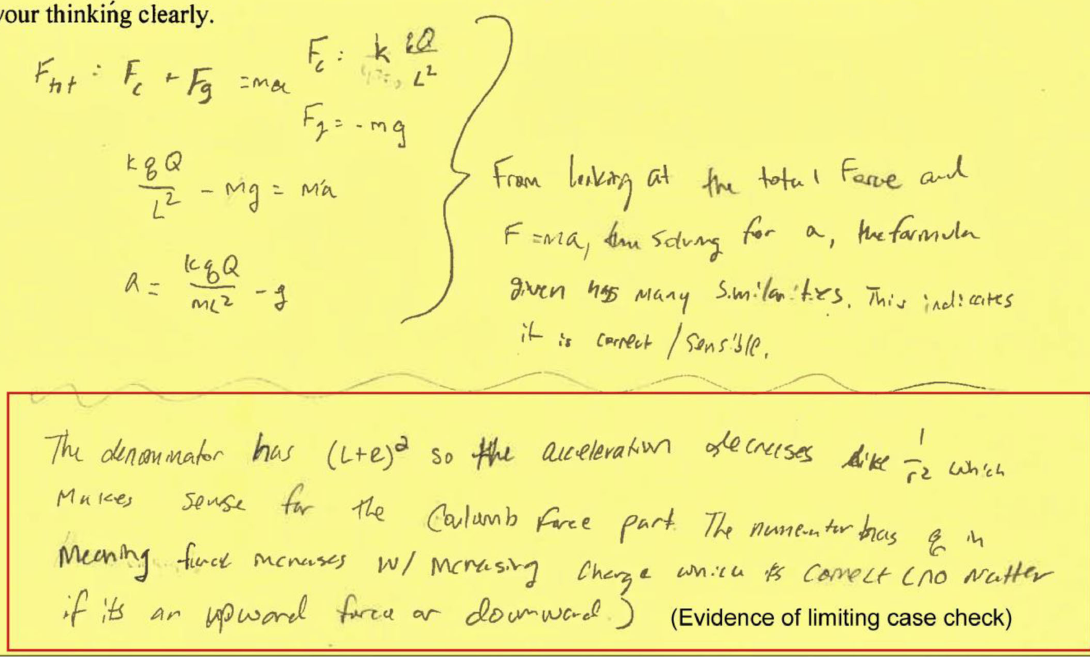
FIG. 7. More elaborate responses eventually forthcoming even with vague prompt, once earlier specific prompts were